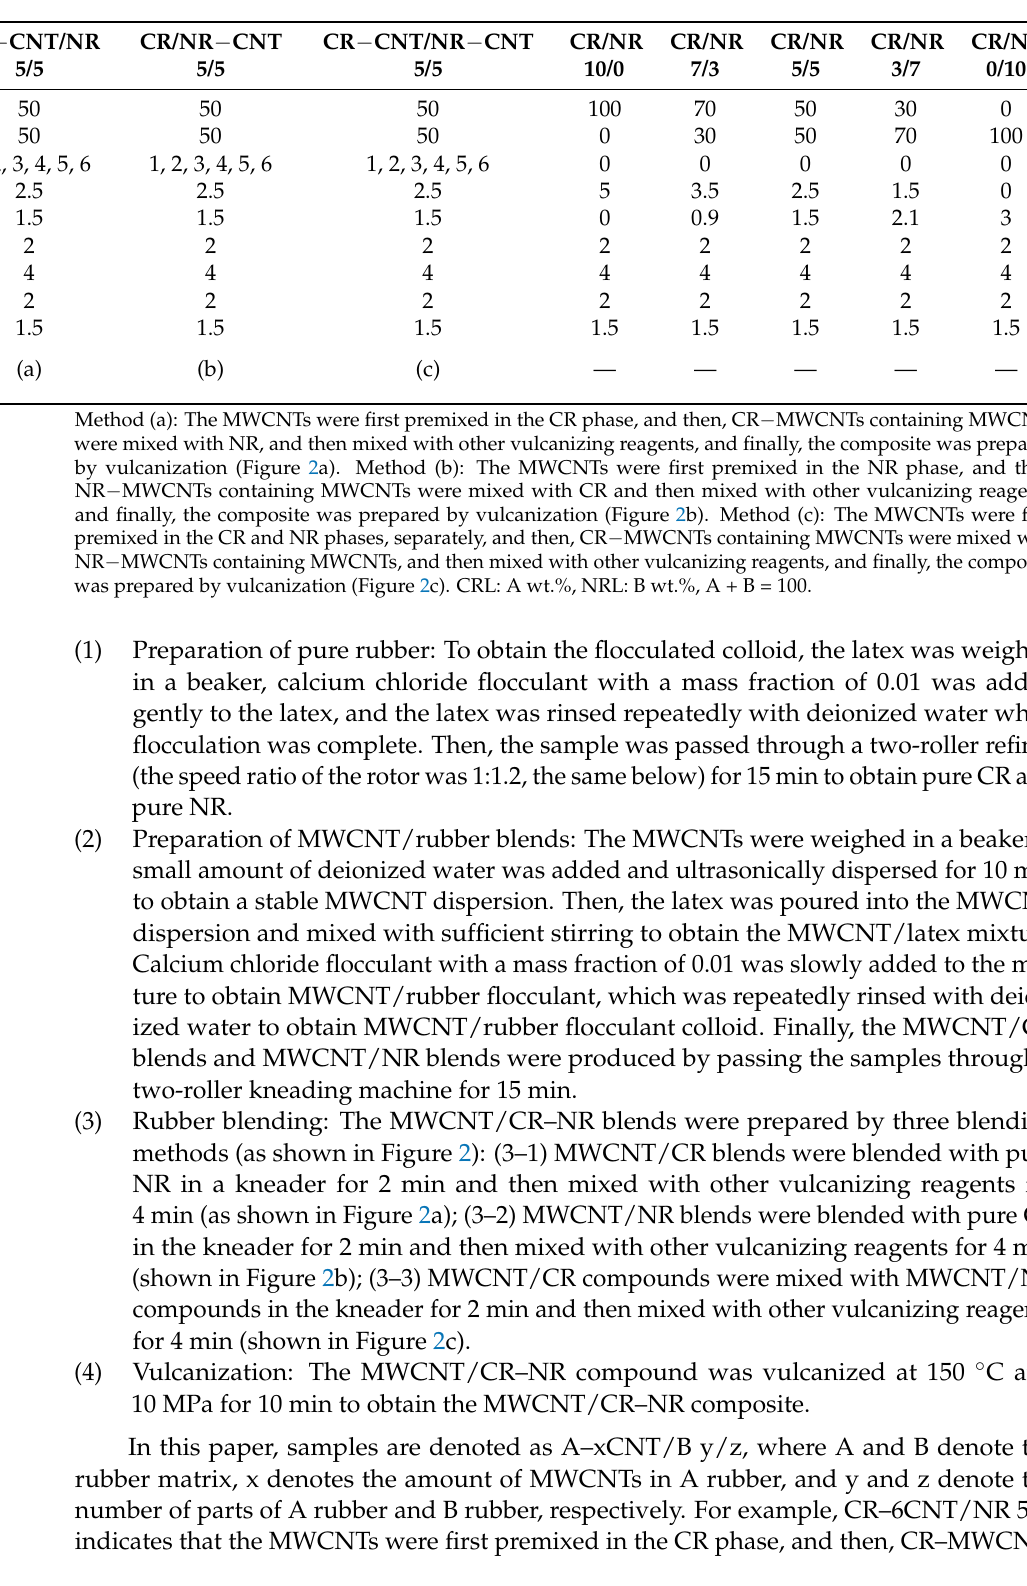
Table 1. The mixing proportions of MWCNT/CR − NR